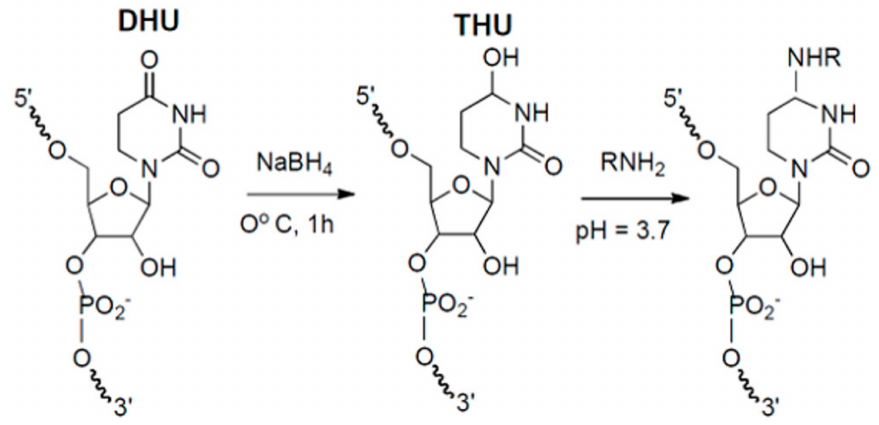
Figure 2. Covalent modification of DHU via THU